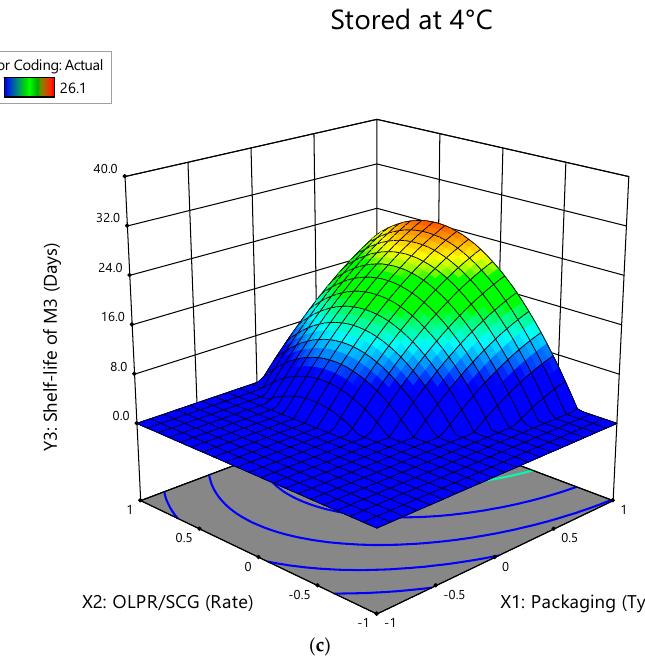
Figure 5. Three-dimensional surface plots for the interactive effect of packaging type and OLPR, SCG, and OLPR/SCG rates on shelf-life (days) during storage at 4 ◦ C: ( a ) M 1 (mushrooms of WS and OLPR mixtures); ( b ) M 2 (mushrooms of WS and SCG mixtures); and ( c ) M 3 (mushrooms of WS and OLPR/SCG